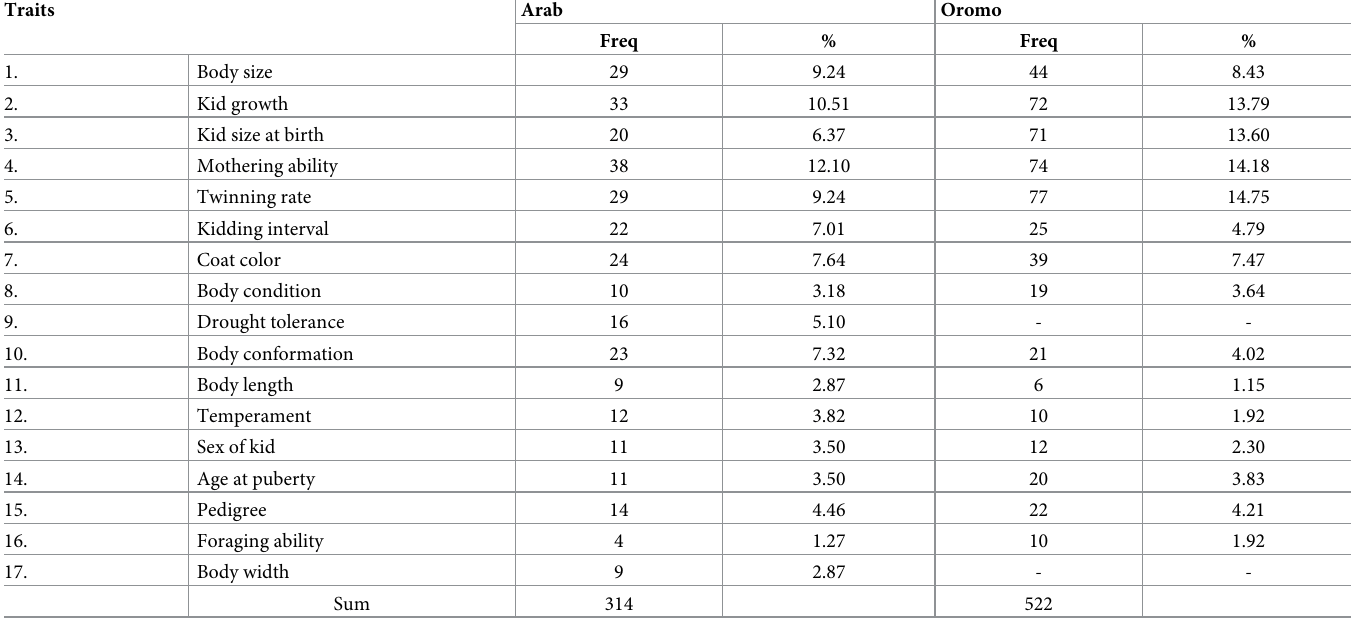
Table 1. List of doe traits in own-flock ranking